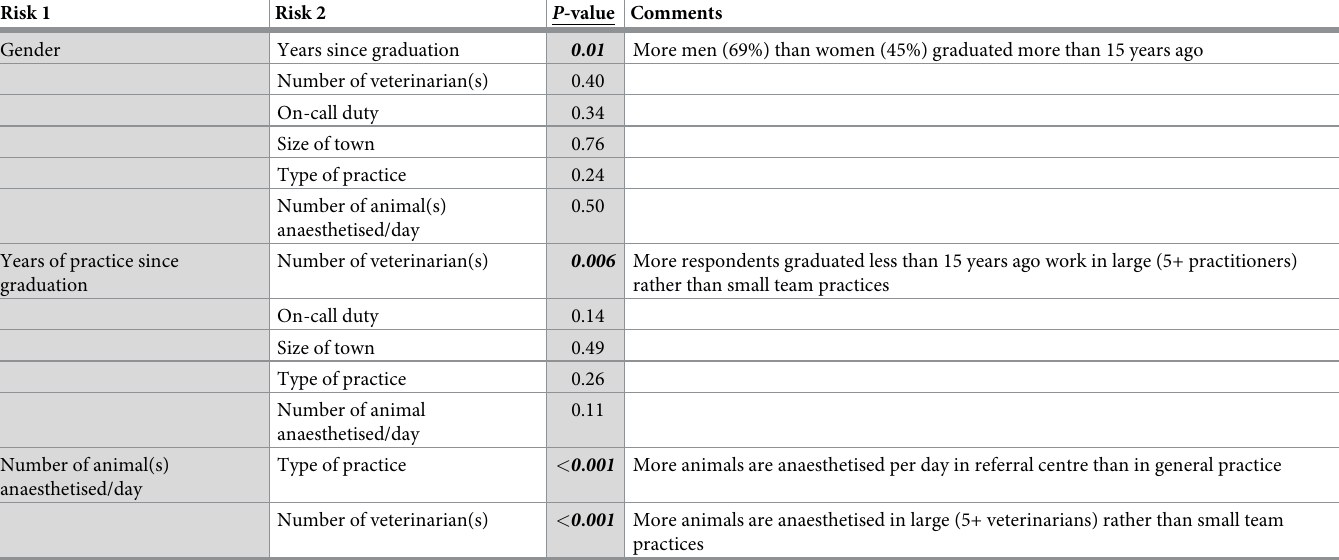
Table 2. Relations between risk factors of English-speaking veterinarians (n = 126) responding to a survey on management of anaesthesia in small animal practices in Canada. Risk 1